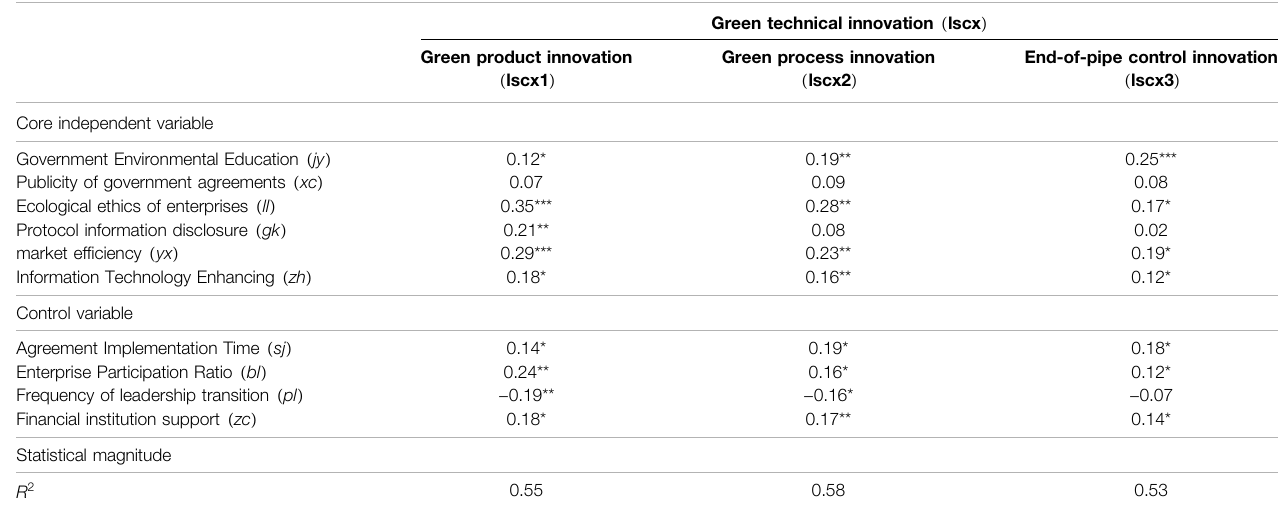
TABLE 6 | Robustness